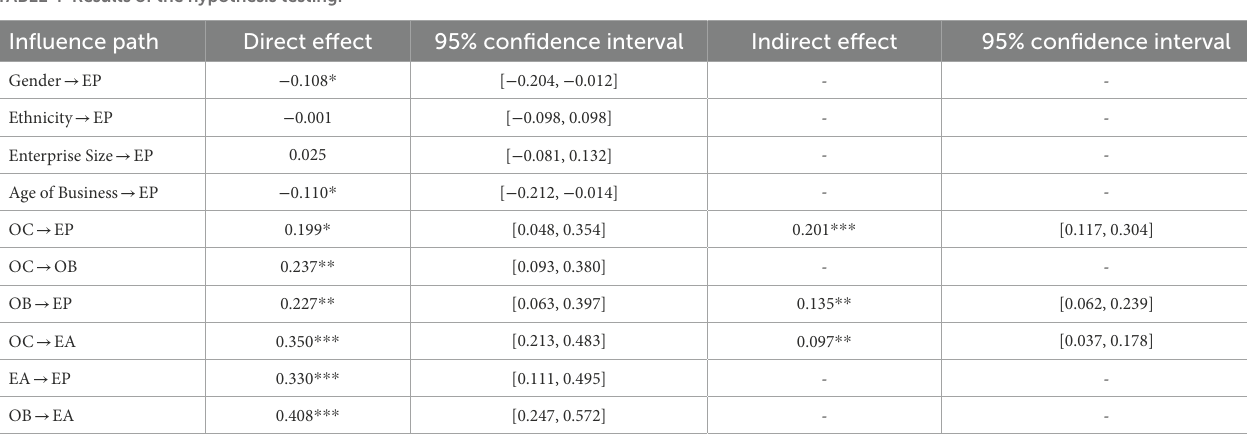
TABLE 4 Results of the hypothesis